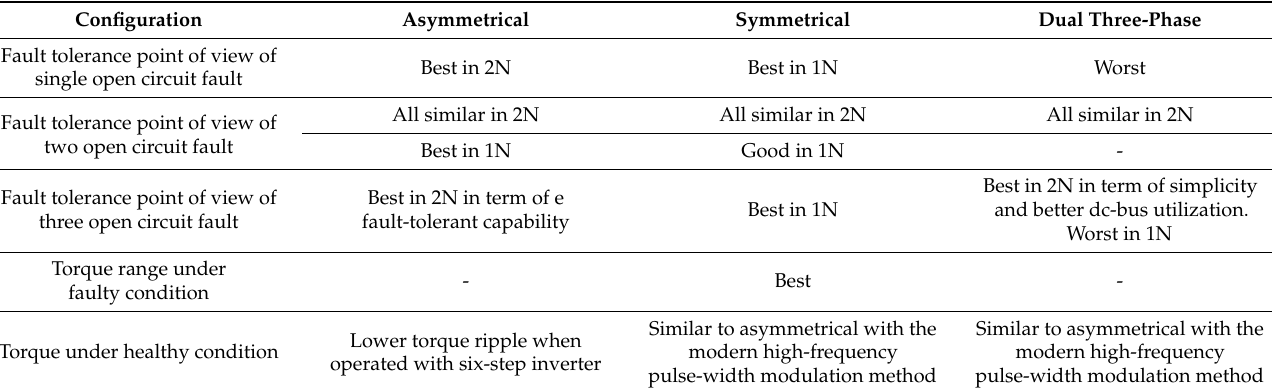
Table 1. Guidelines for the selection of the most suitable six-phase machine for each specific re- quirement.